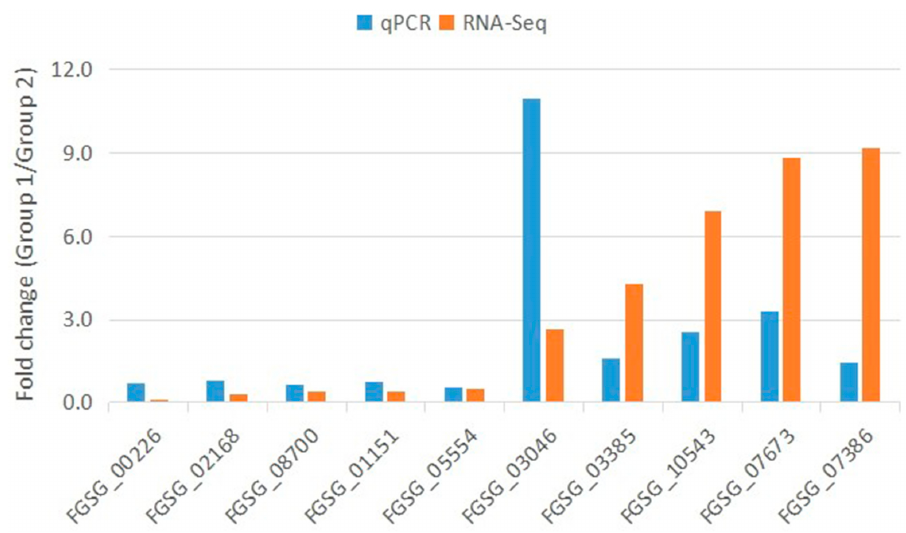
Figure 6. qRT-PCR validation of RNA-seq data. The expression of 10 selected genes was examined via real-time RT-PCR. For each qRT-PCR validation, three technical replications were performed. The beta-tubulin gene was used as an internal control.